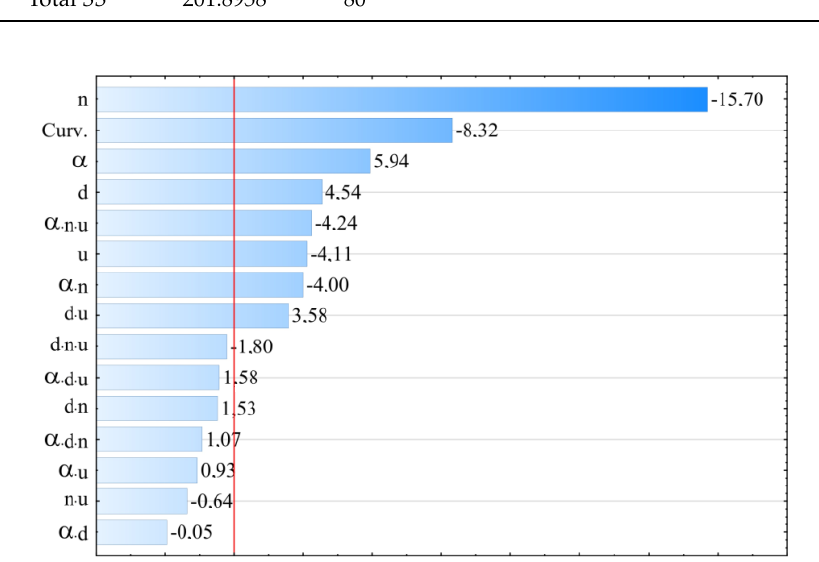
Figure 7. Pareto plots of the standardized effects of empirical model of tensile strength σ ; the vertical line in plot corresponds to the arbitrarily chosen level of significance (p = 0.05).